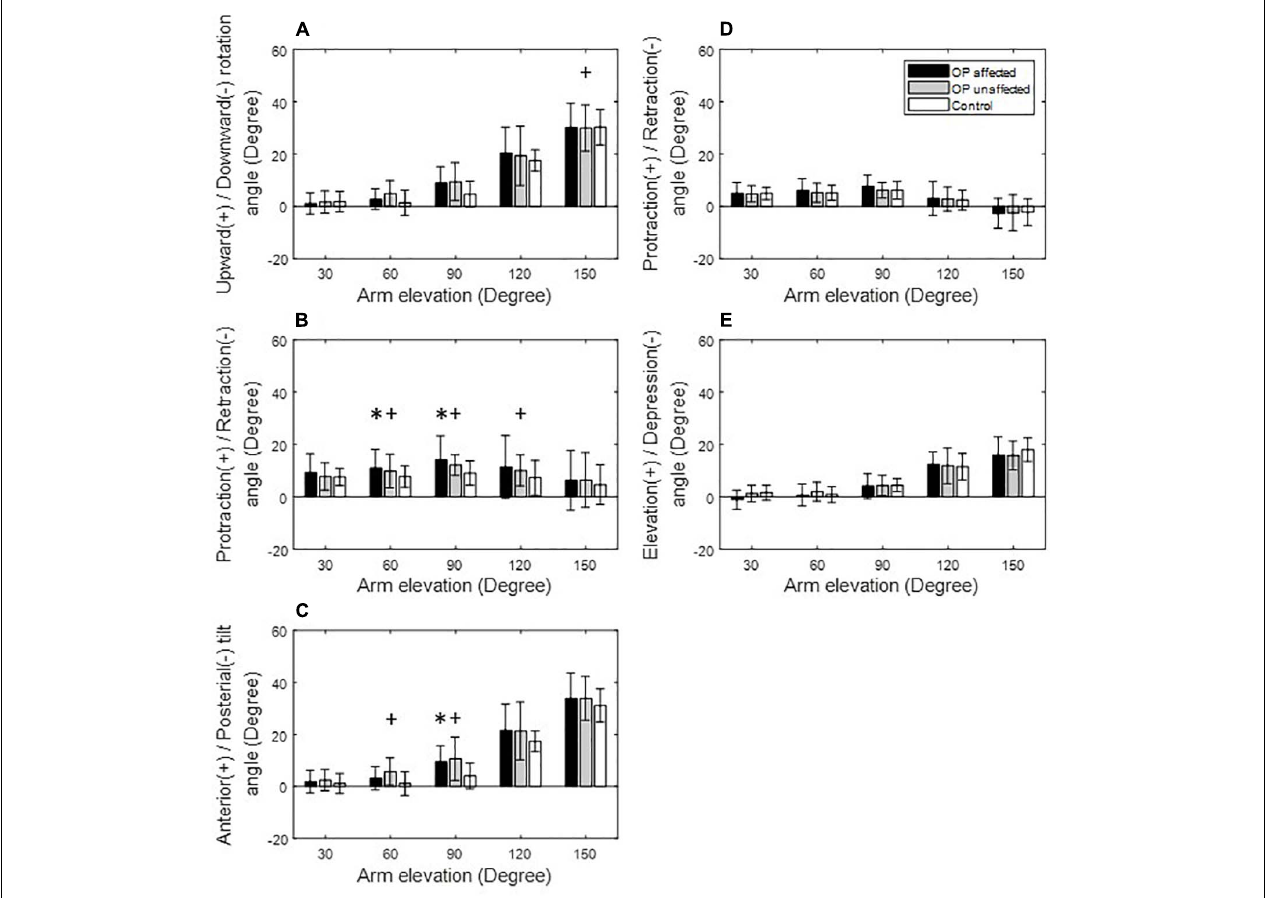
FIGURE 5 | Means and standard deviations of the kinematic components of the scapula (A–C) and clavicle (D,E) for the affected side (black bars), unaffected side (gray bars) of the patients, and for healthy controls (white bars) during arm elevation in the sagittal plane. Symbol “ ∗ ” indicates a significant difference between the affected side and healthy controls. Symbol “+” indicates a significant difference between the unaffected side and healthy